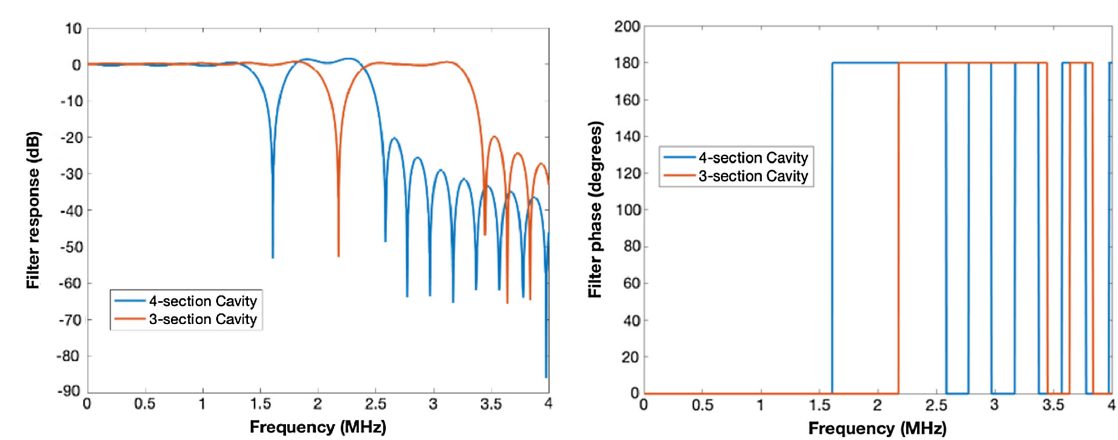
f Þ filter response and phase for three- and four-section FIG. 5. H cav ð